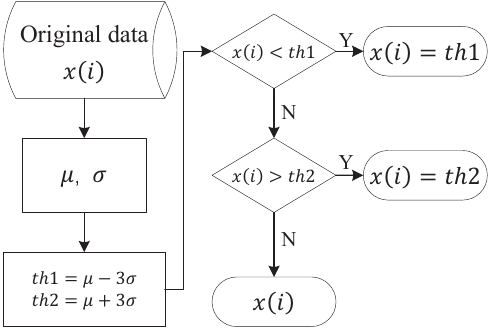
Figure 3. The flowchart of the data